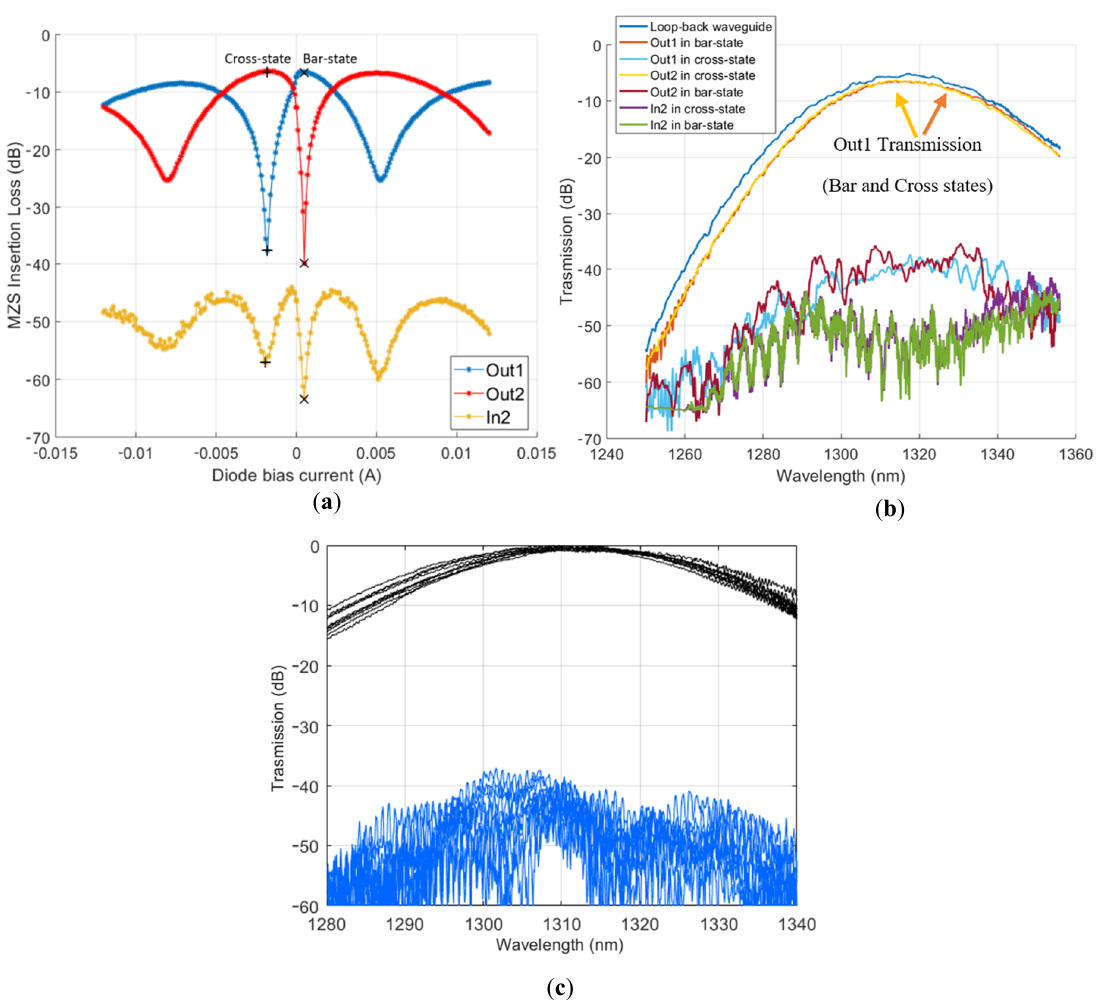
Figure 9. ( a ) Insertion loss measured of 2 × 2 MZI by varying the biased current separately in the two-phase shifters. ( b ) Transmission signal spectrum (in dB) of the loop-back waveguide and the MZI in bar and cross-states. ( c ) Measured transmission spectra (in dB) of waveguide crossing (dark lines) and crosstalk recorded (blue lines).